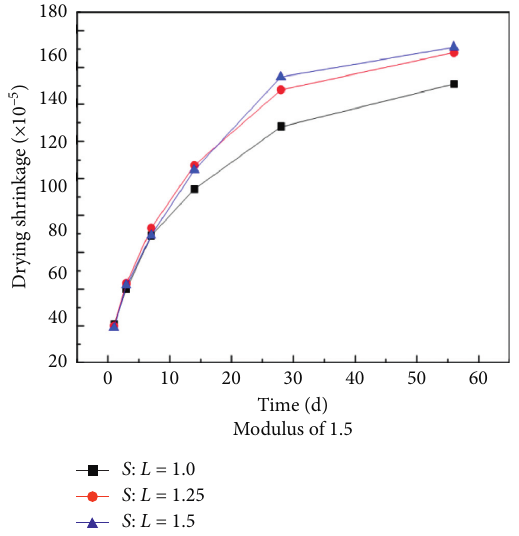
Figure 9: Influence of the solid/liquid ratio on the drying shrinkage of